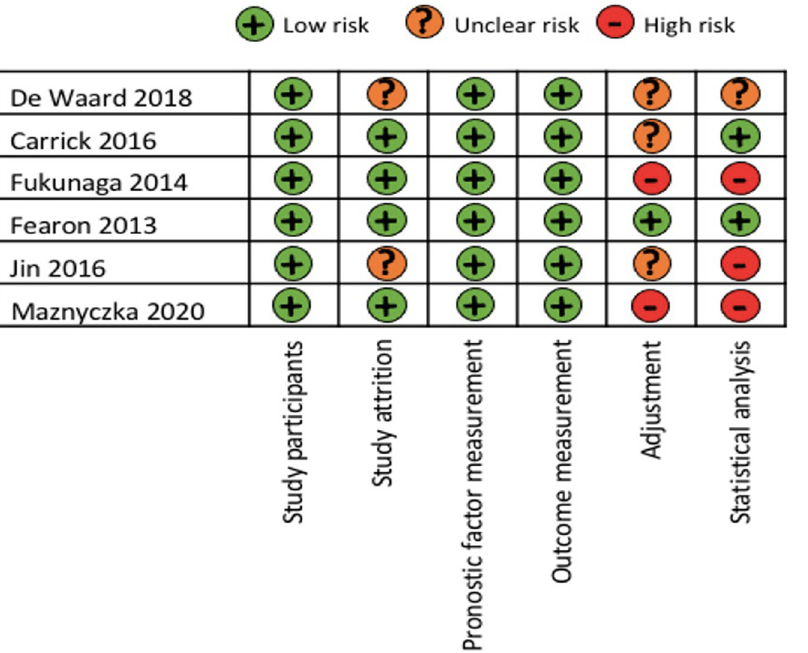
Fig 2. Quality of included studies using QUIPS tool. QUIPS = Quality in Prognostic